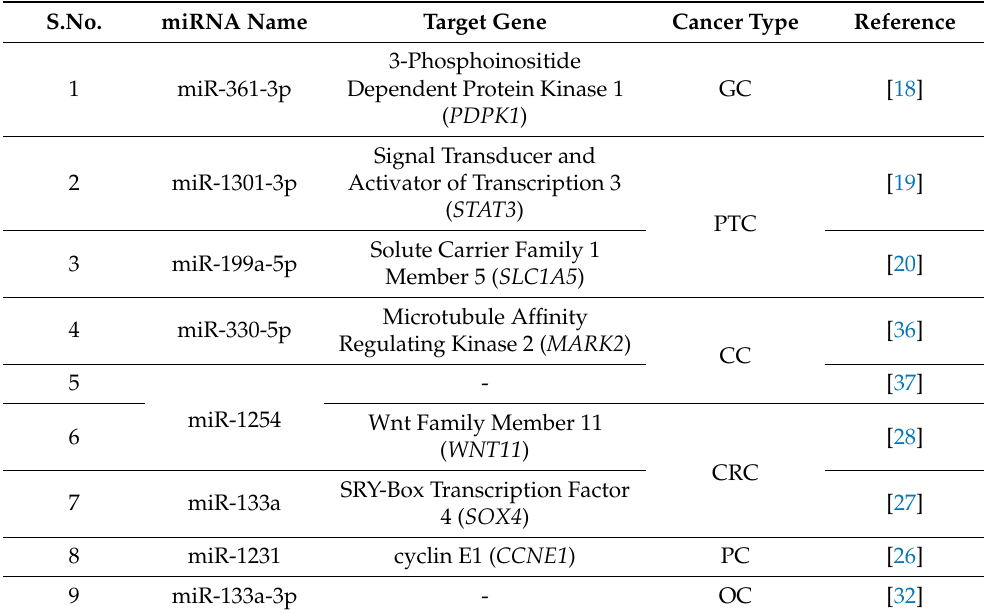
Table 2. List of miRNAs targeted by ABHD11-AS1 lncRNA in human cancers. S.No. miRNA